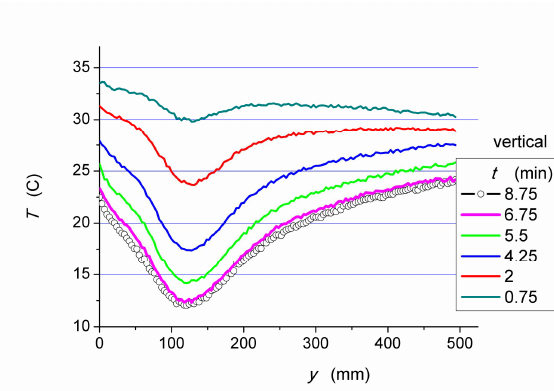
Fig. 4. Temperature distribution along y coordinate (see Fig.